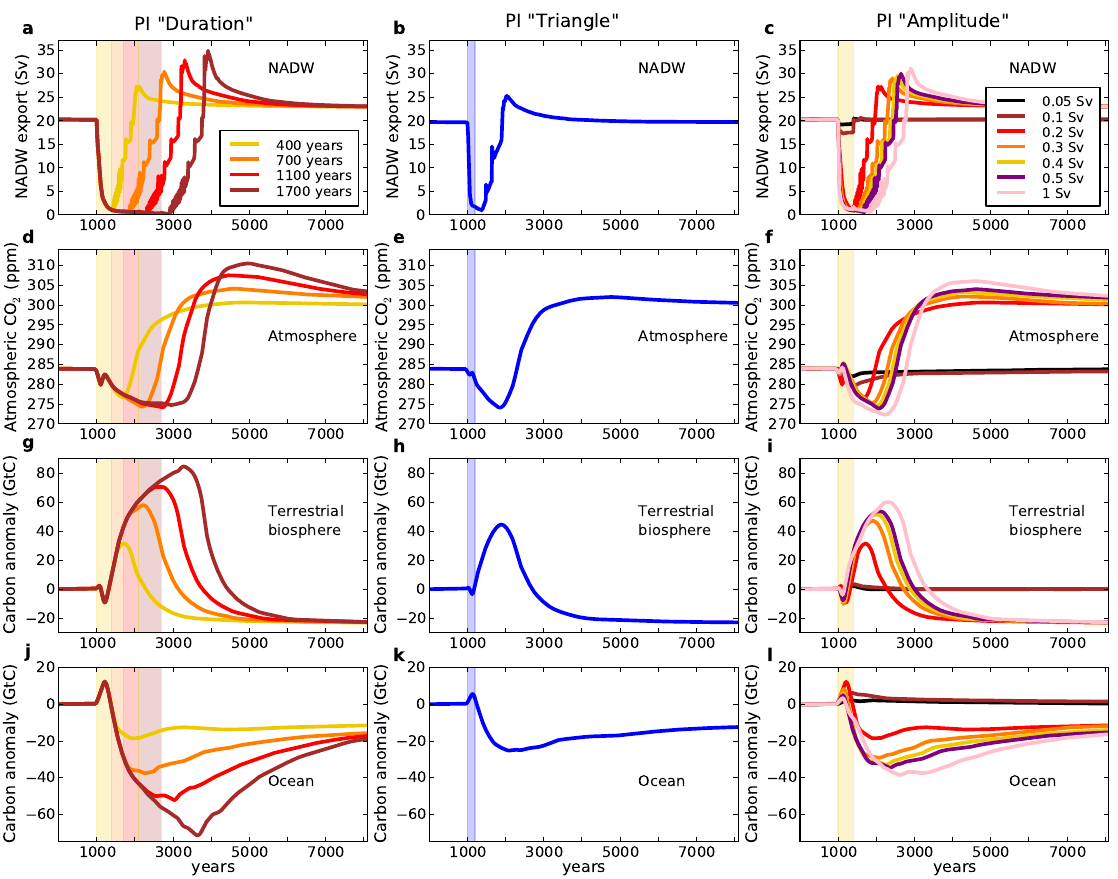
Fig. 2. Evolution of (a, b, c) NADW export (Sv) (maximum of the AMOC), (d, e, f) atmospheric CO 2 (ppm), (g, h, i) carbon content anomaly in the terrestrial biosphere (GtC) and (j, k, l) carbon content anomaly in the ocean (GtC) during the simulations with the Preindustrial (PI) background climate state. The fresh water flux is added into the North Atlantic and varies as described in Fig. 1 for the three types of experiments: (a, d, g, i) “Duration”, (b, e, h, k) “Triangle” and (c, f, i, l) “Amplitude”.